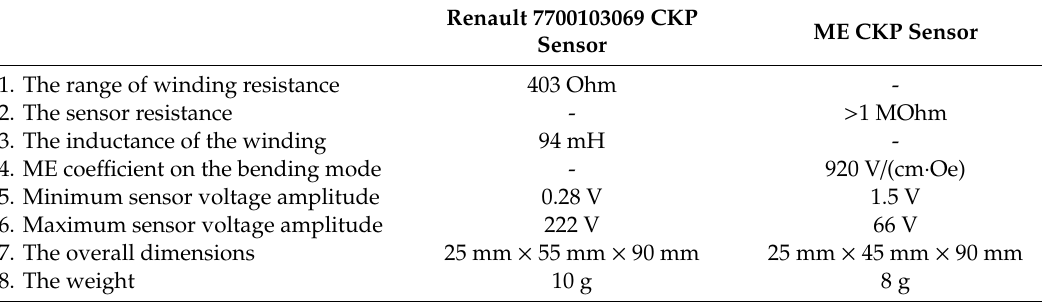
Table 2. Approximate technical characteristics of the CKP sensors.